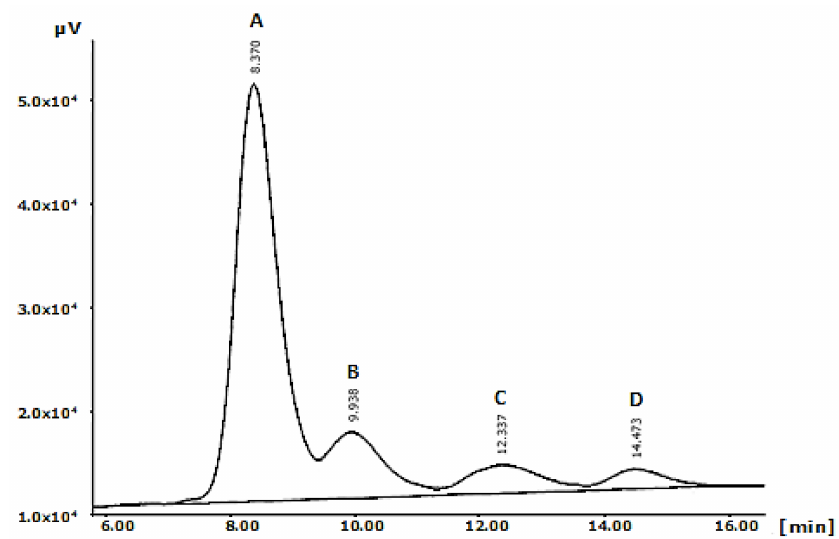
Figure 3. Chromatogram of Halimione portulacoides sugars. A: maltose, B: sucrose, C: glucose, and D: fructose.